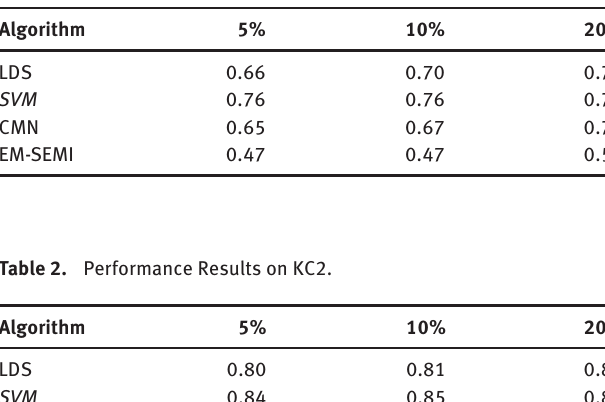
Table 1. Performance Results on